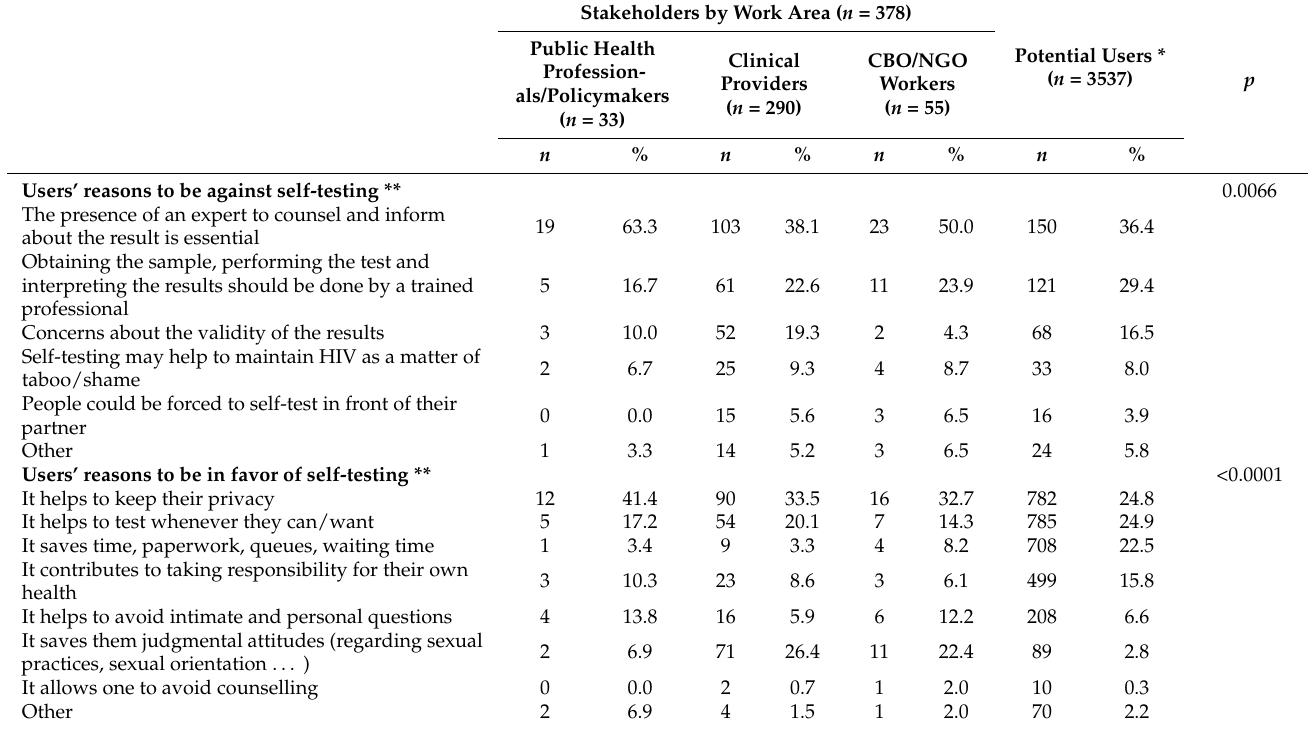
Table 3. Stakeholders’ opinion of reasons that the public has in favor/against self-testing vs. opinions of potential